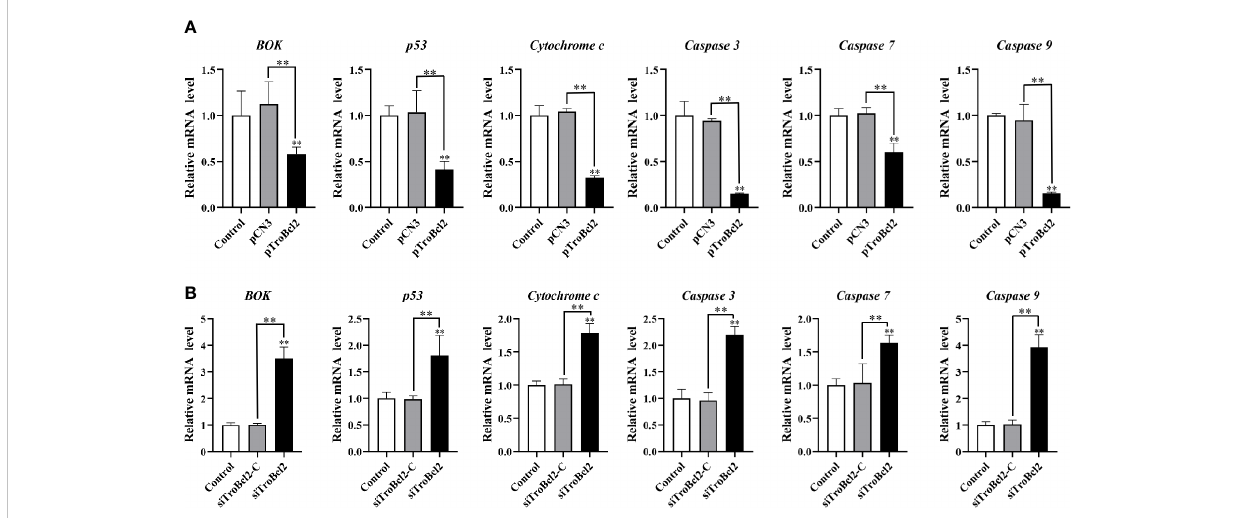
FIGURE 8 Effect of TroBcl2 overexpression and knockdown on the expression of apoptosis-related genes following LPS stimulation. qRT-PCR analysis of the expression levels of apoptosis-related genes in GPS cells transfected with pTroBcl2 and pCN3 (A) or siTroBcl2 and siTroBcl2-C (B) upon LPS treatment. Non-transfected cells treated with LPS were as the control. Error bars display means ± SD (N = 3). N, experimental number. ** P < 0.01.